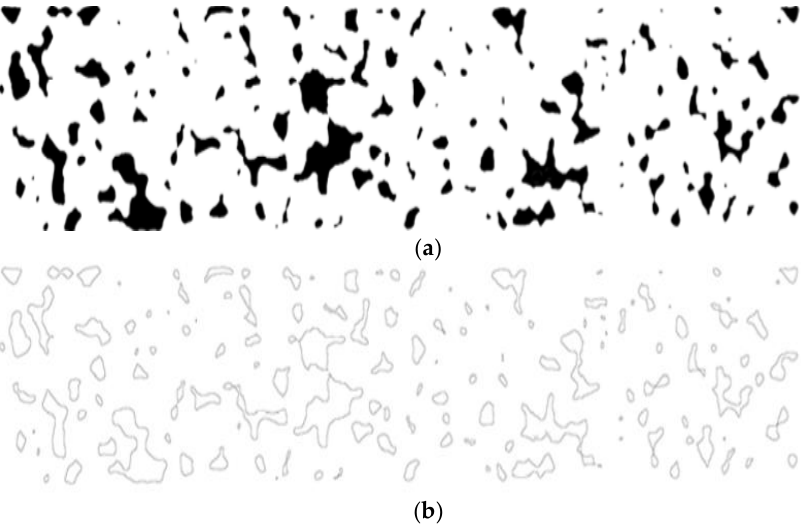
Figure 5. Image Process, ( a ) Image segmentation, ( b ) Voids extraction.